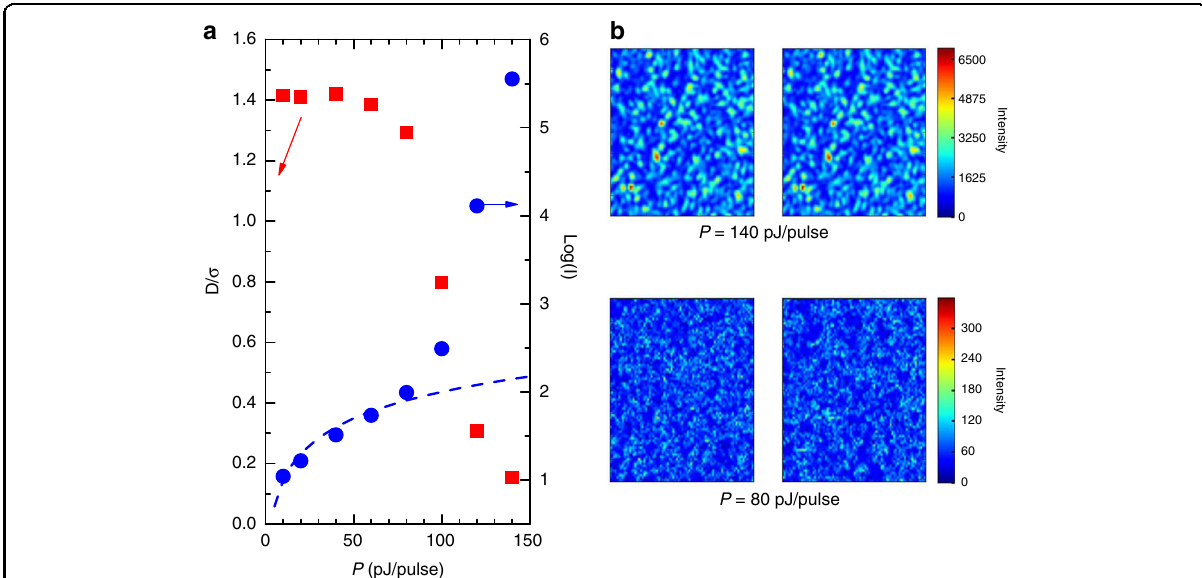
Fig. 10 Qualitative testing of the spectral coherence of light pulses generated by a switched QDM. a Evolution of the indicator of speckle formation D/ σ and of the intensity I of the pulses delivered by the switched QDM micropillar (blue dots) as a function of the pump intensity. For P below ≈ 70 pJ/pulse, I follows the linear trend expected for pure SpE, shown as a dotted blue line. For larger P ’ s, a superlinear increase of I reveals the onset of ampli fi cation by stimulated emission from the QD ensemble. b CCD camera images of the output facet of a Te fl on fi lm, upon irradiation by pulses emitted by the switched micropillar for two different P ’ s. For each energy, we show two images obtained from independent acquisitions. Speckle formation is clearly observed in the strong pumping